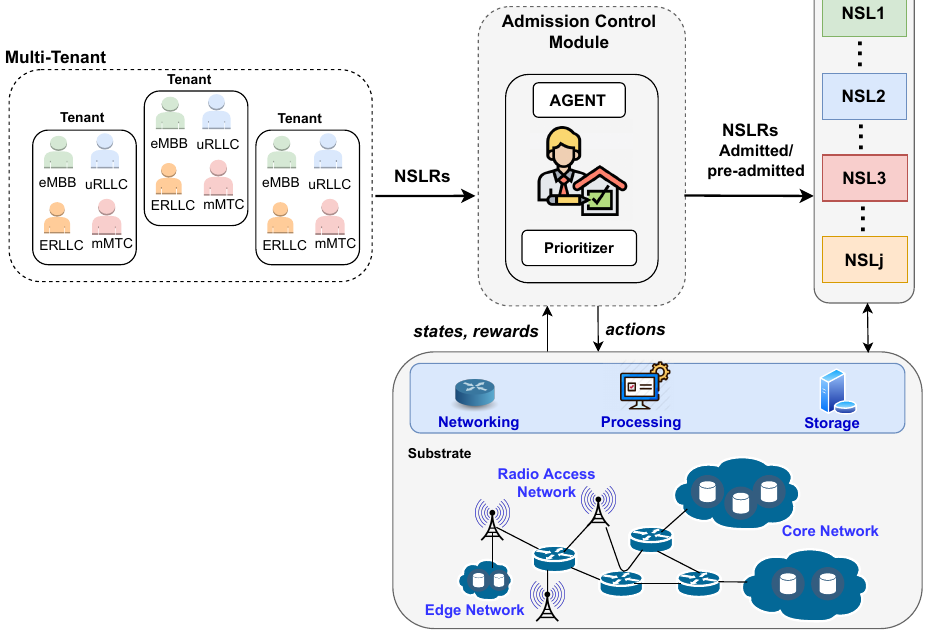
Figure 3. RL/DRL-based admission control